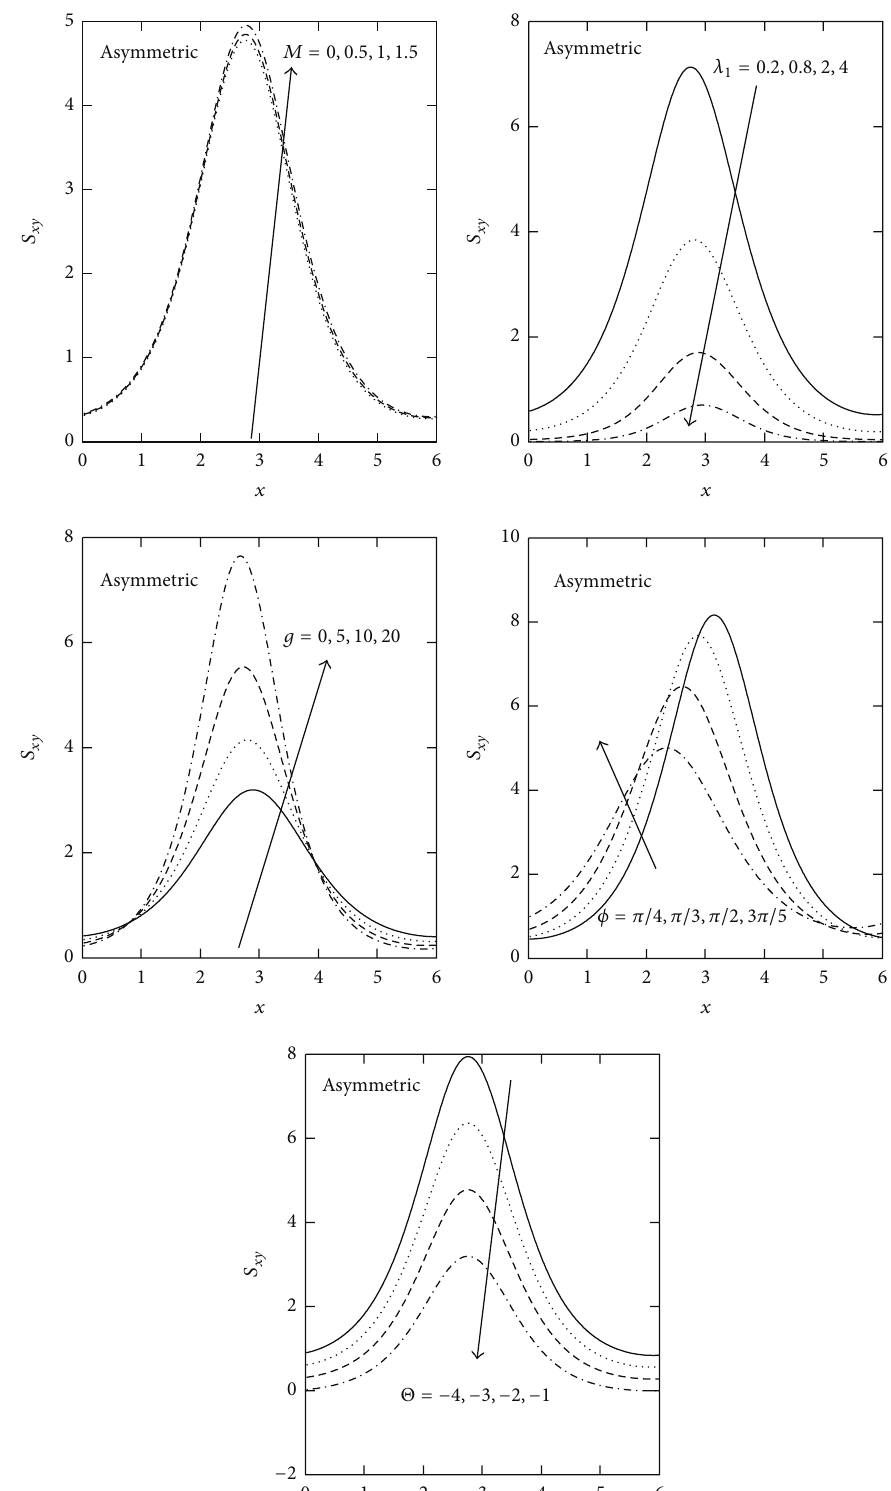
Figure 7: Variation of 𝑆 𝑥𝑦 with influence of 𝑀 , 𝜆 1 , Θ , 𝑔 , and 𝜙 with respect to 𝑥